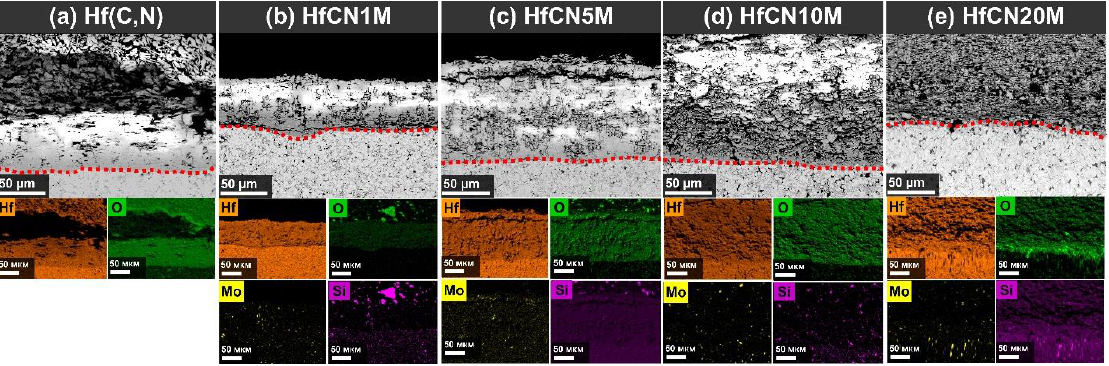
Figure 7. Micrographs of Hf(C,N) and Hf(C,N)-MoSi 2 samples after oxidation in a furnace at 1000 °C (red dashed line is the sample’s surface).